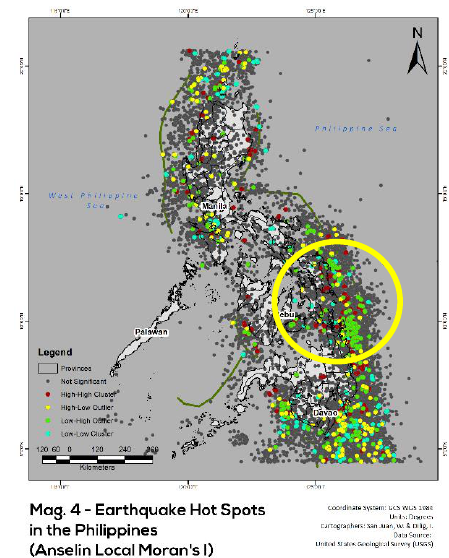
Figure 10. Mag.4-Earthquake Clusters in the Philippines